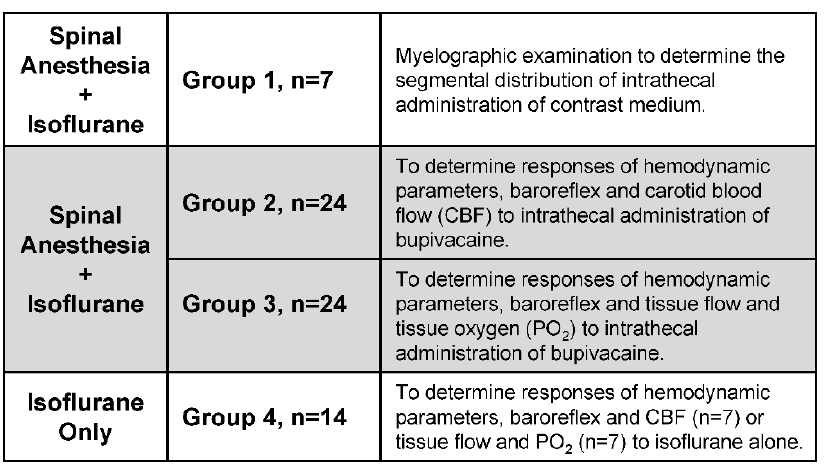
Figure 1. Experimental setup and animals used in each group in this study.